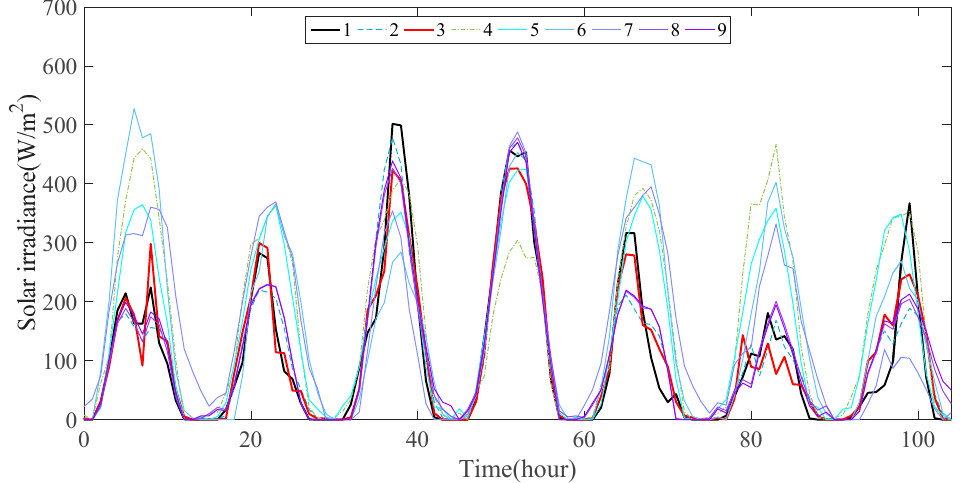
Figure 12. Actual and forecasted solar irradiance at Sioux Falls station. Figure legend: 1-Actual data, 2-Forecast results using single fusion model, 3-Forecast results using classified fusion models, 4-Forecast results of 0-level WD model (standard ANN model), 5-Forecast results of 1-level WD model, 6-Forecast results of 2-level WD model, 7-Forecast results of 3-level WD model, 8-Forecast results of 4-level WD model, 9-Forecast results of 5-level WD model.